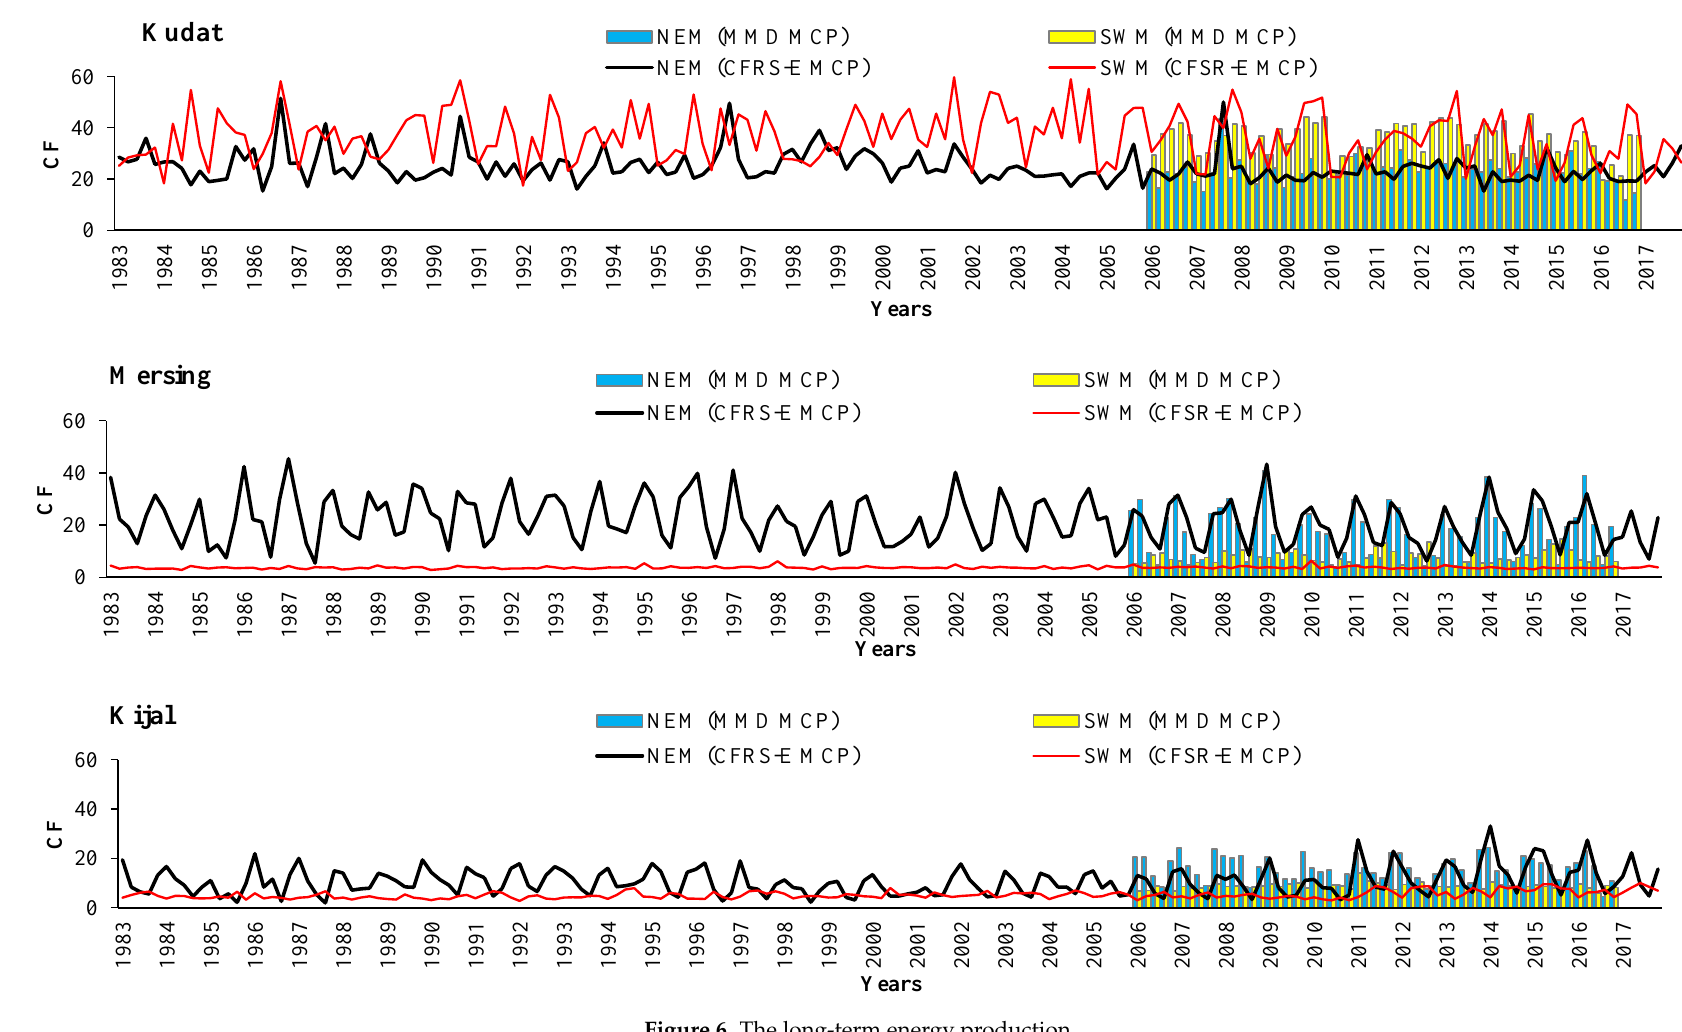
Figure 6. The long-term energy production.